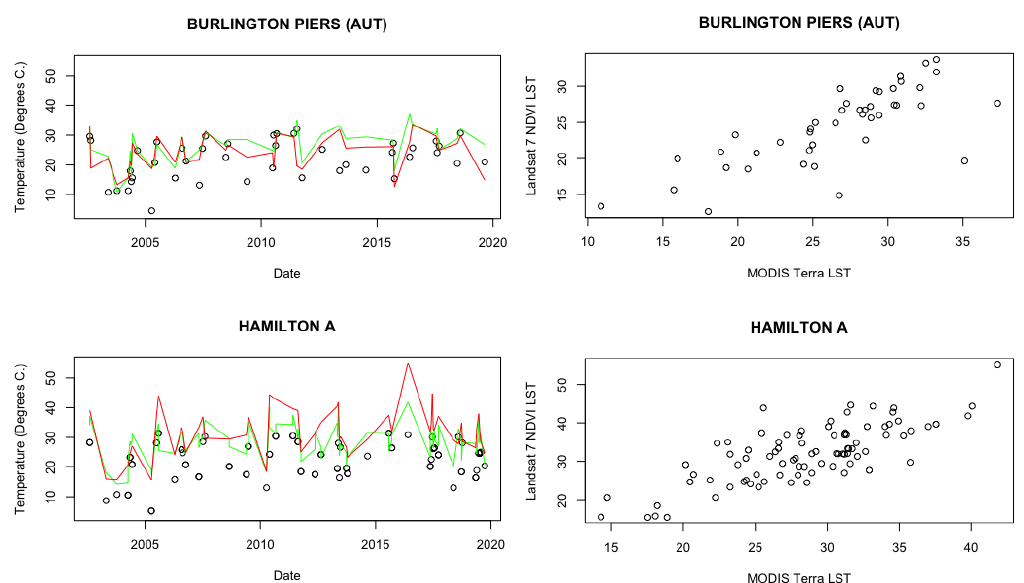
Figure 2. The time series ( left ) and scatterplots ( right ) of the Landsat 7 NDVI-derived LST and MODIS Aqua LST along with average air temperature at the stations with the most data points during the summer. The green line represents MODIS LST, the red line represents Landsat 7 LST, and the black points represent average air temperature observations. Burlington Piers is a lakeside station and Hamilton A is within agricultural land.